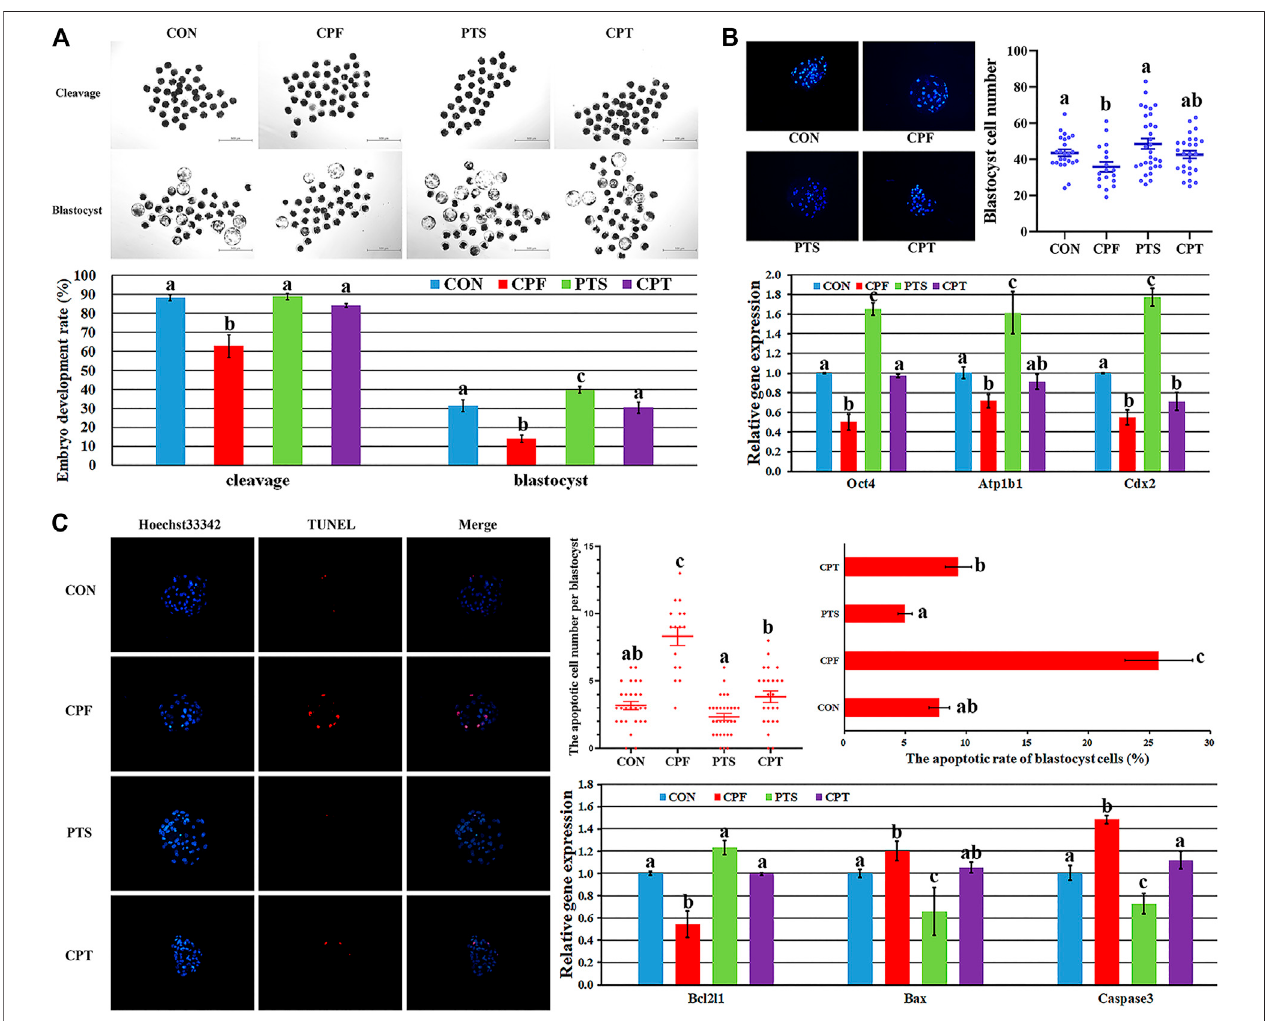
FIGURE 6 | The development competence, quality and apoptosis of early embryos derived from oocytes treated with CPF or/and PTS. (A) , the morphologies and rates of cleavage and blastocyst. (B) , the morphology and number of blastocyst cells and relative expression of blastocyst quality related genes. (C) , the morphology, numberandrateofblastocystcellapoptosisandrelativeexpressionofapoptosisrelatedgenes. a-c Valuesforacertaingroupwithdifferentsuperscriptsdiffersigni fi cantly ( p <